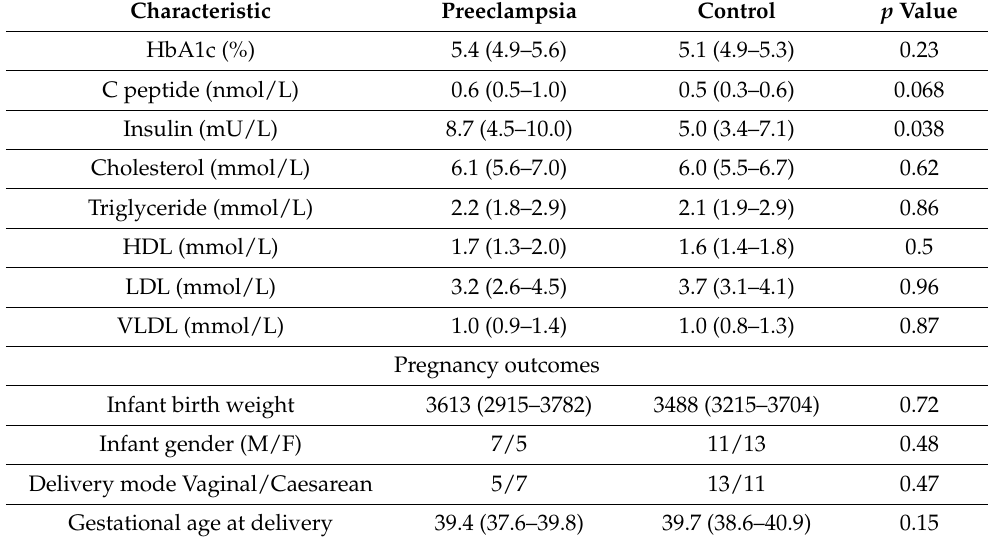
Figure 1. Oral microbiota diversity. Alpha diversity for oral samples of pregnant women with preeclampsia (DPE) ( n = 12) compared to control ( n = 24) group at 36 weeks pregnancy using Shan- non ( A ) and Chao-1 ( B ) indices. Beta diversity was assessed with PCoA ( C ), RDA ( D ) and Anosim ( E ) analysis. Red symbols signify the women in the control group and blue symbols the women who developed preeclampsia. Microbial diversity between oral samples (beta-diversity) from pregnant women who developed preeclampsia and normal controls was analysed by unsupervised Princi- pal Coordinates Analysis (PCoA) and supervised Redundancy Analysis (RDA); its signif- icance was tested using the Anosim statistic. The PCoA analysis for oral samples showed some clustering of the samples from the women who developed preeclampsia (Figure 1C), which was also observed in the supervised RDA clustering analysis ( p = 0.04, Figure 1D).